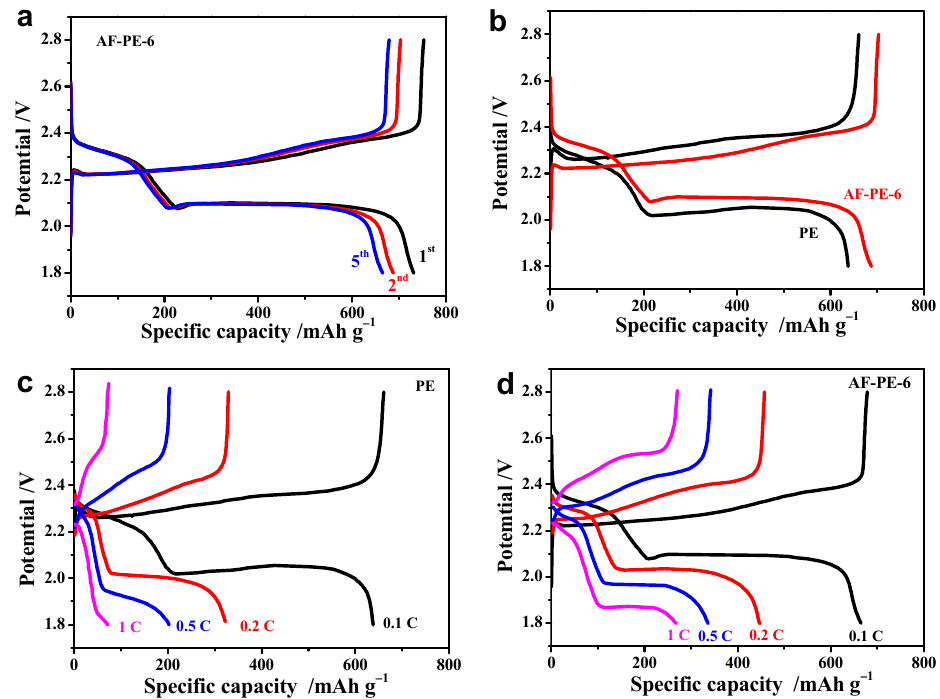
Figure 3. ( a ) The 1st, 2nd and 5th cycle of GCD curves of AF-PE-6 cell; ( b ) The GCD curves of pristine PE and AF-PE-6 cells. The GCD curves at different C rates of ( c ) pristine PE; and ( d ) AF-PE-6 cells.